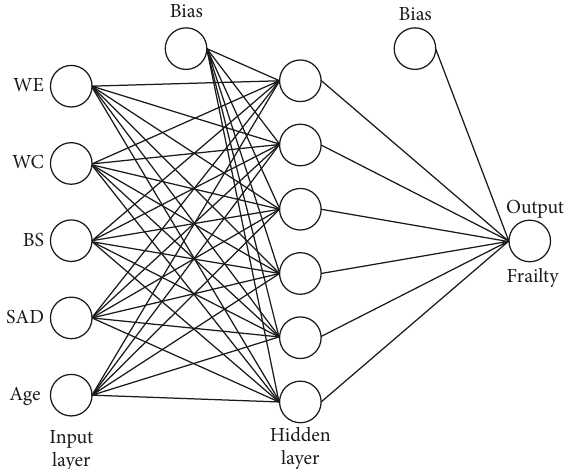
Figure 1: Neural network configuration of anthropometric mea- sures and frailty in older adults who were assisted at primary health care centers. WE: weight; WC: waist circumference; BS: bicipital skinfold; SAD: sagittal abdominal